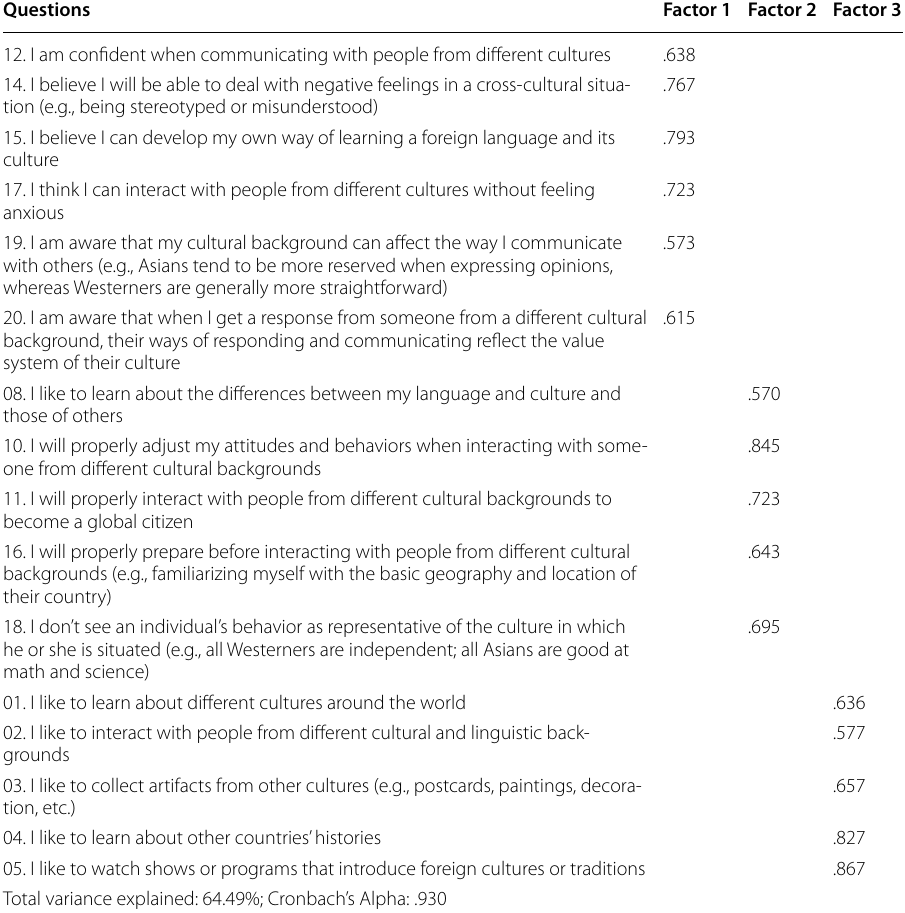
Table 4 Factor loading for teenage EFL learners’ intercultural competence (N